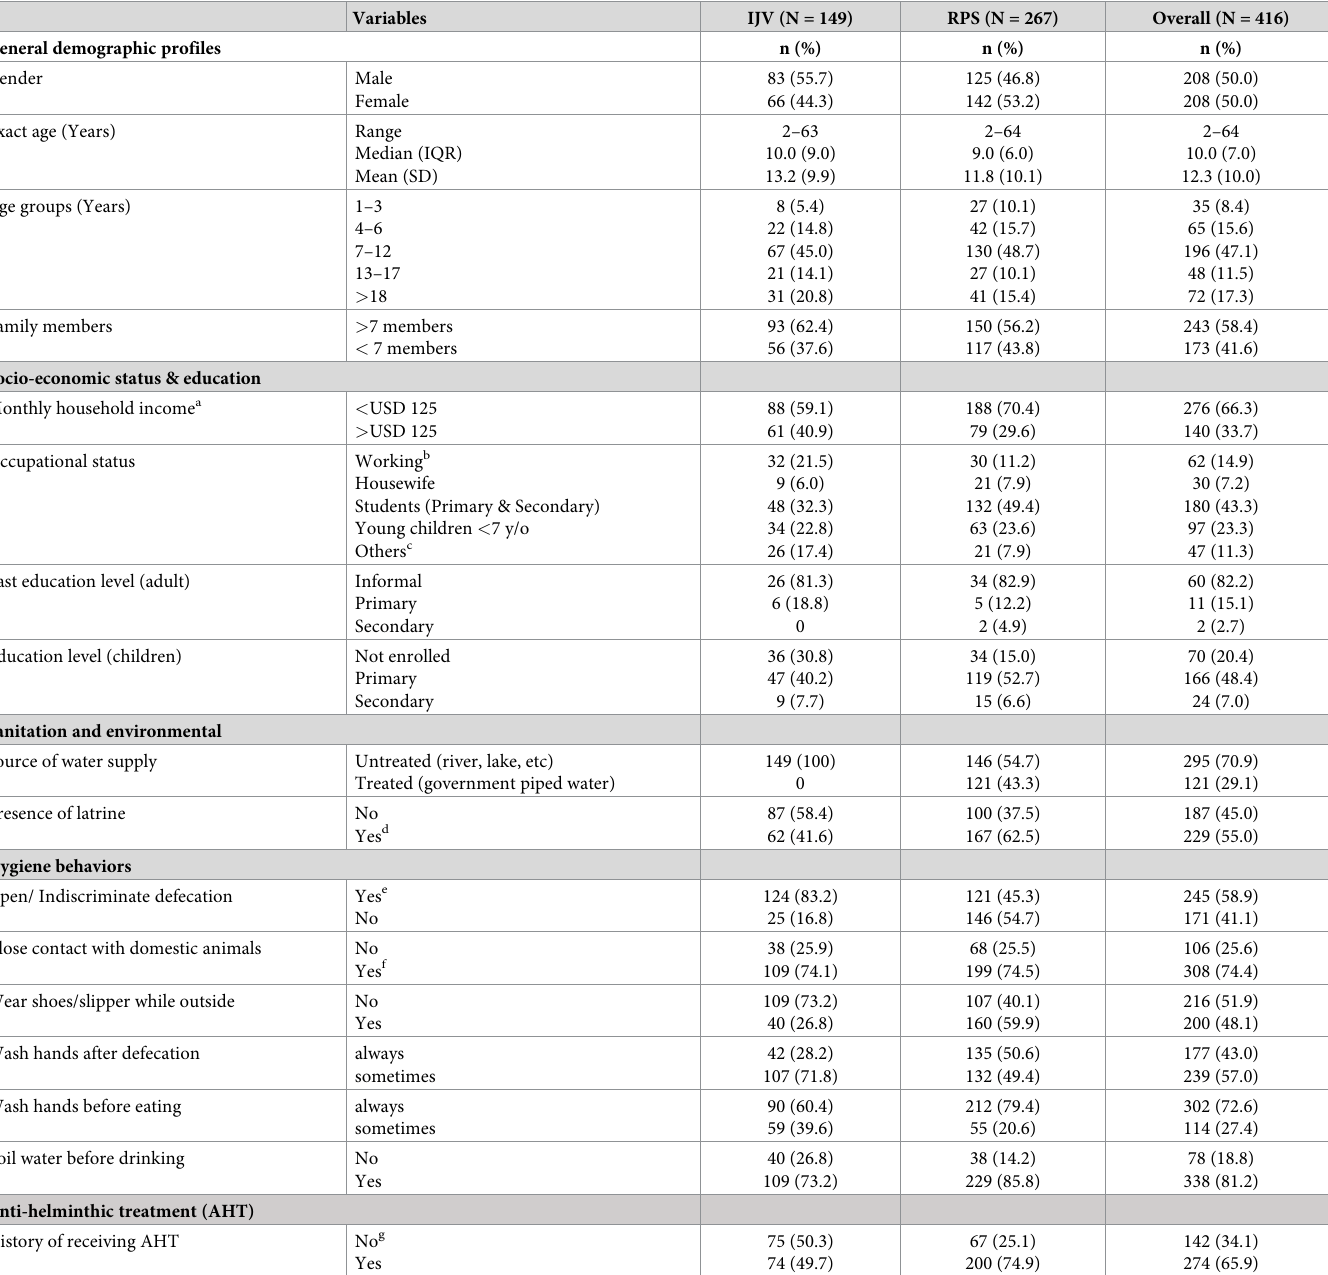
Table 2. General demographic profiles, socioeconomic, environmental conditions and behavior characteristics of Negrito participants based on community